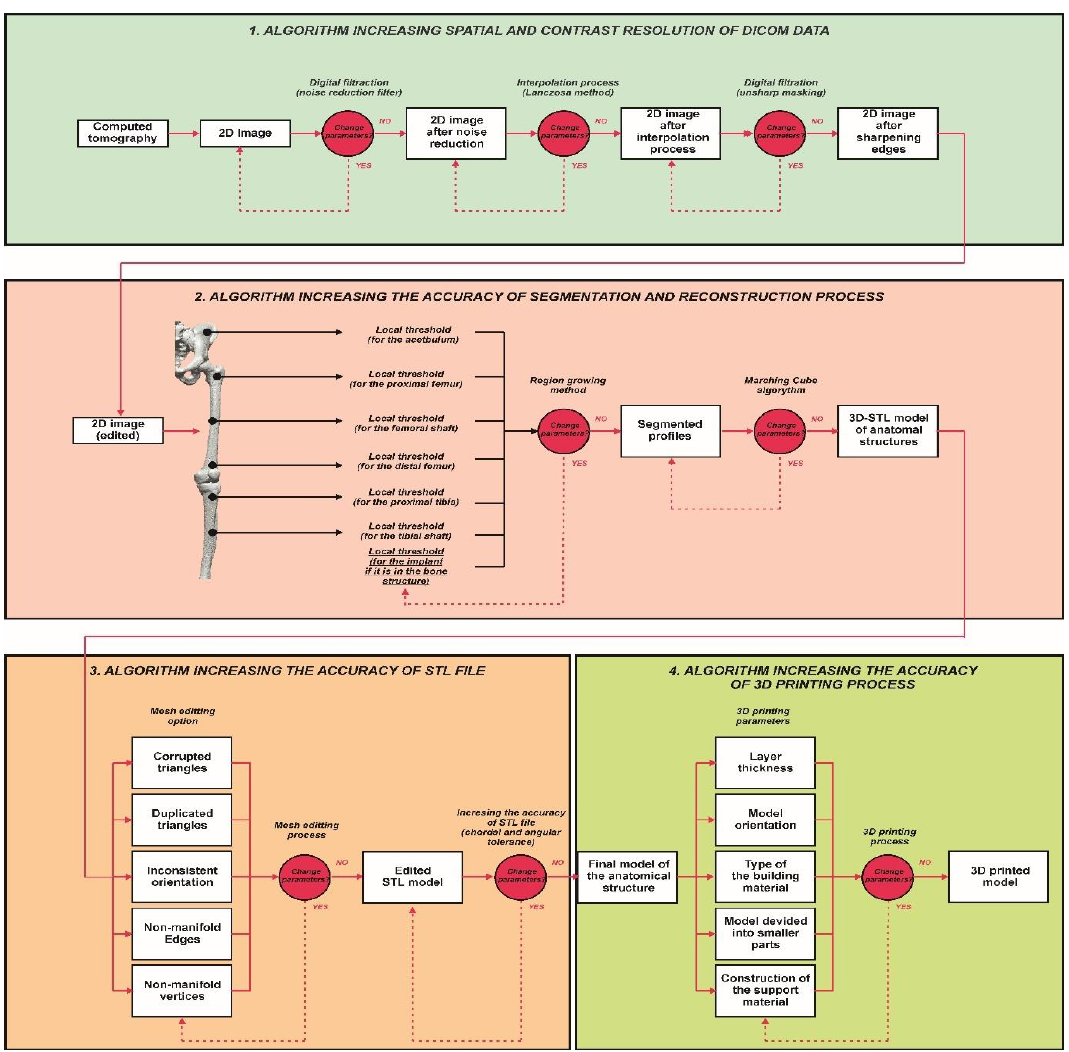
Figure 4. Procedure applied in the